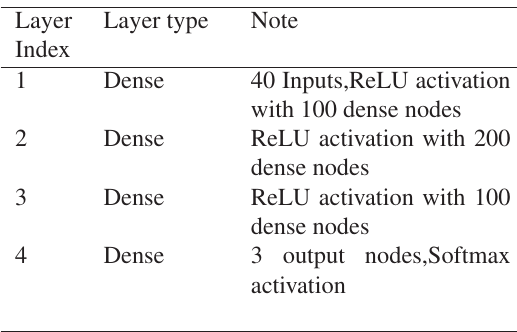
Figure 11: Audio waveform of American